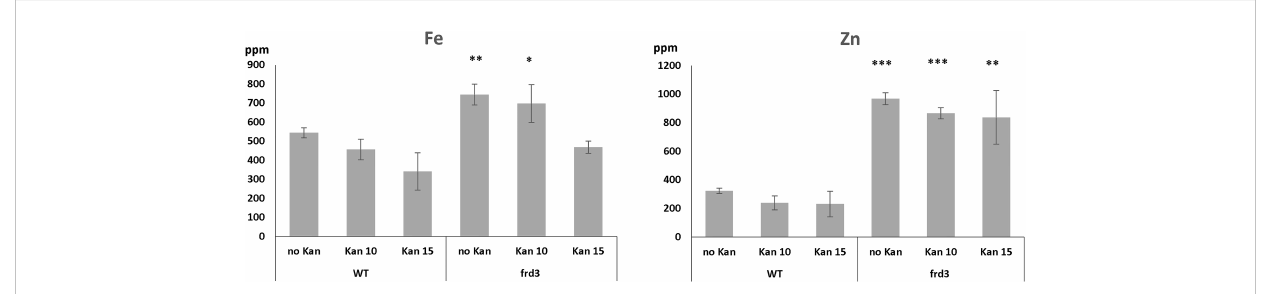
FIGURE 7 Iron and zinc concentrations in WT and frd3 mutants grown for 10 days on MS with 0,10 or 15 mg/l Kan. ppm = part per million. Error bars represent standard deviation. *, ** and *** indicate signi fi cantly different ( p <0.05, p <0.01 and p <0.001 respectively) from WT control grown under the same condition (Student t -test).